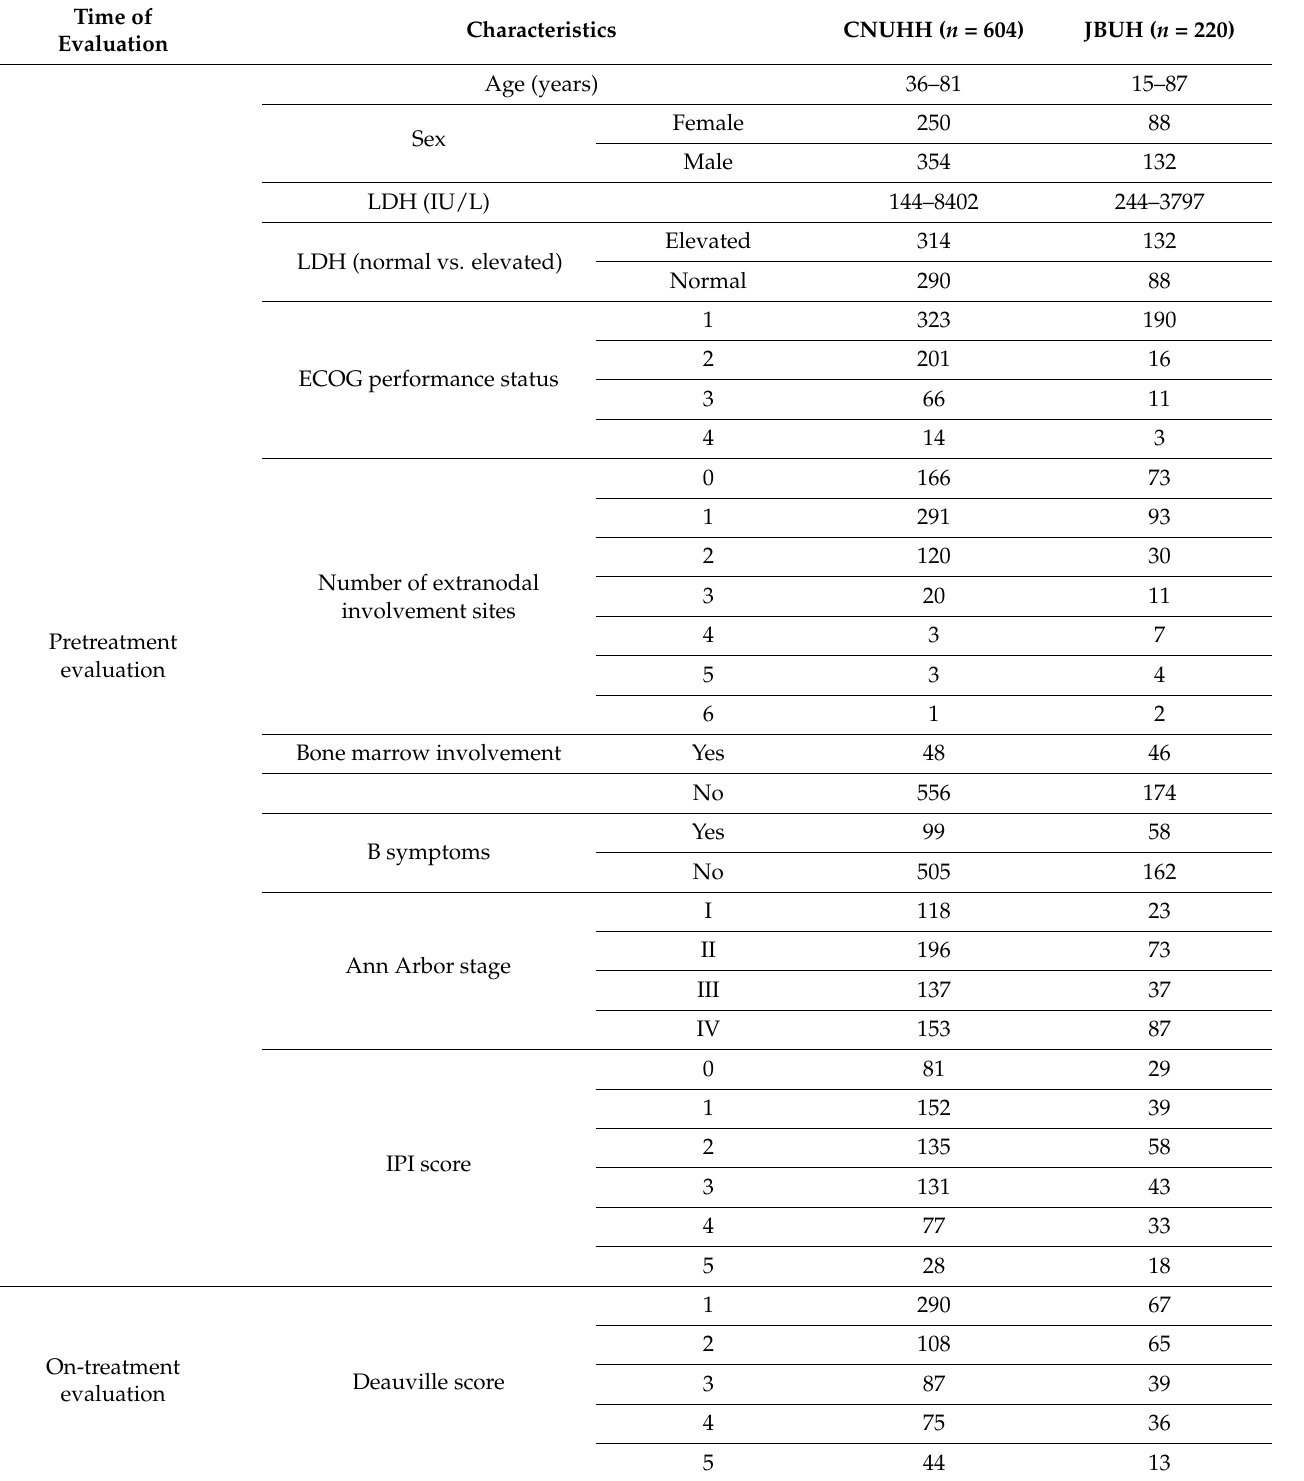
Table 1. Patient characteristics at different treatment